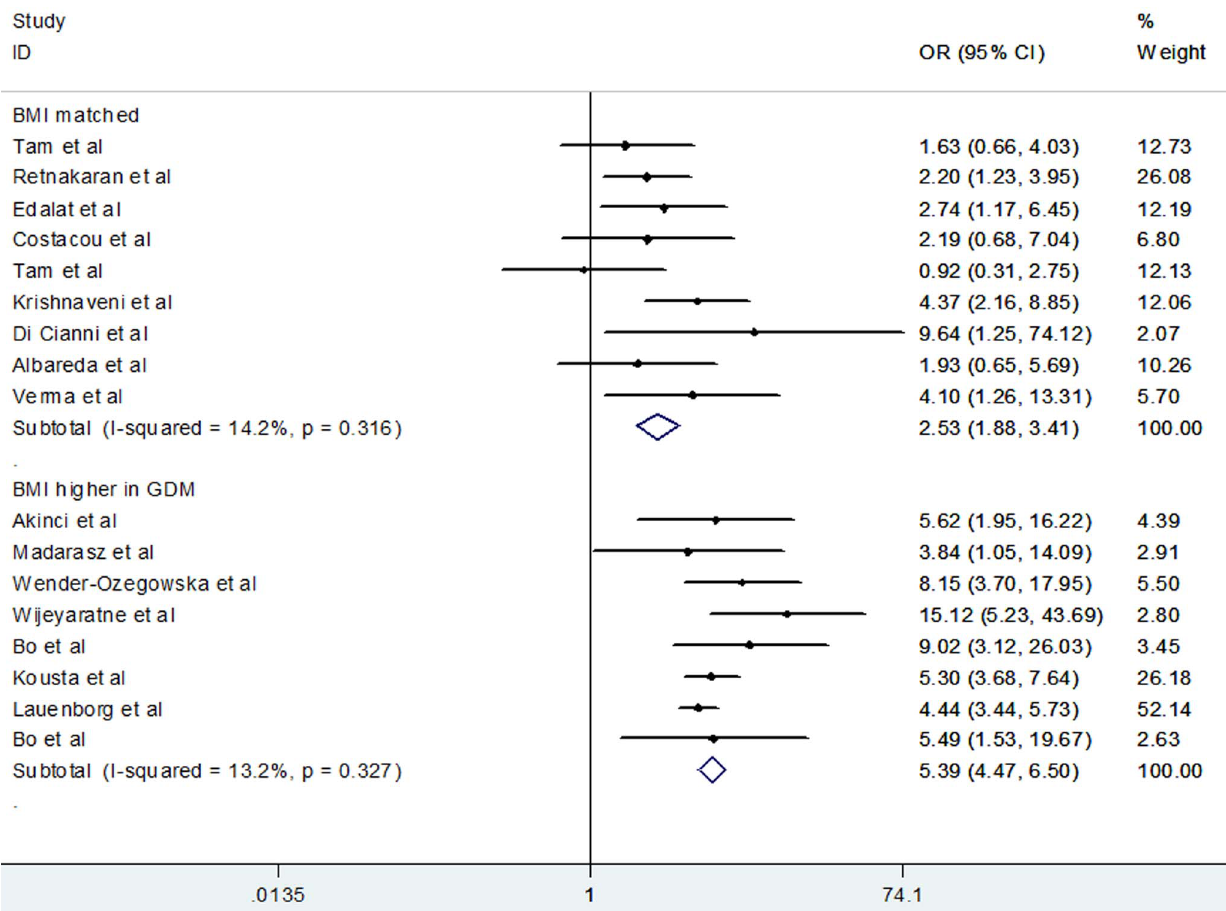
Figure 4. Forest plot of risk of metabolic syndrome after gestational diabetes mellitus grouped by body mass index (BMI).